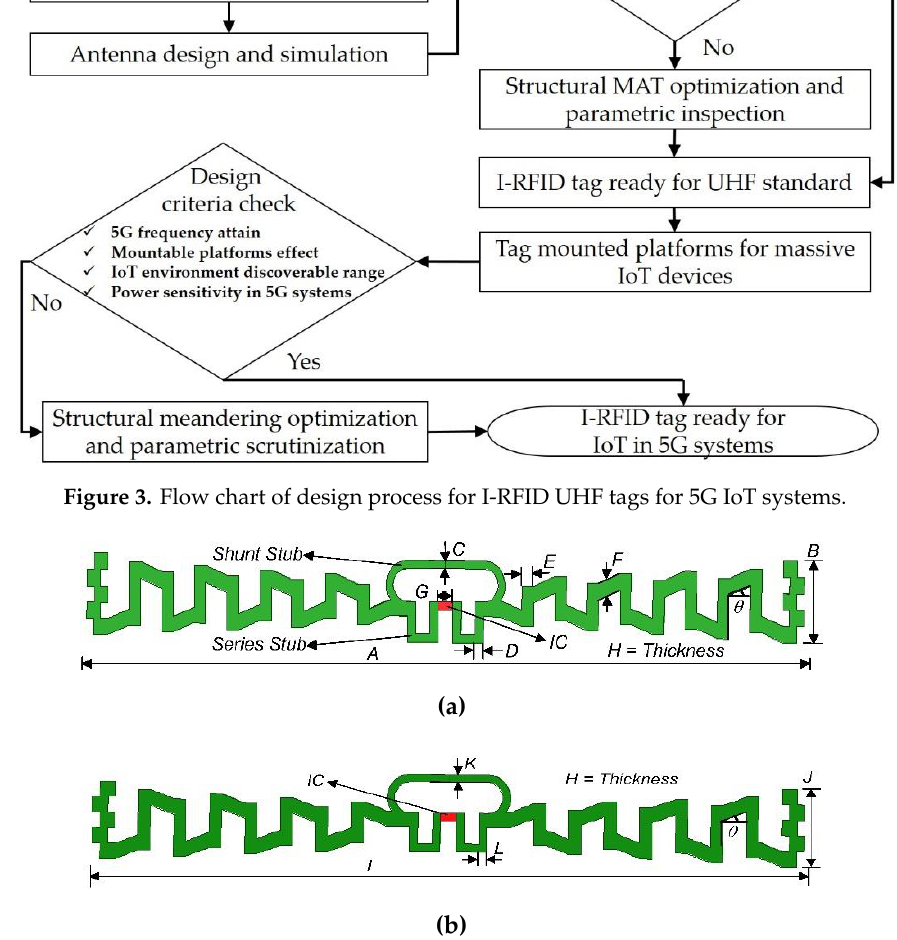
Table 1. Geometric boundaries of UHF I-RFID tag antennas.